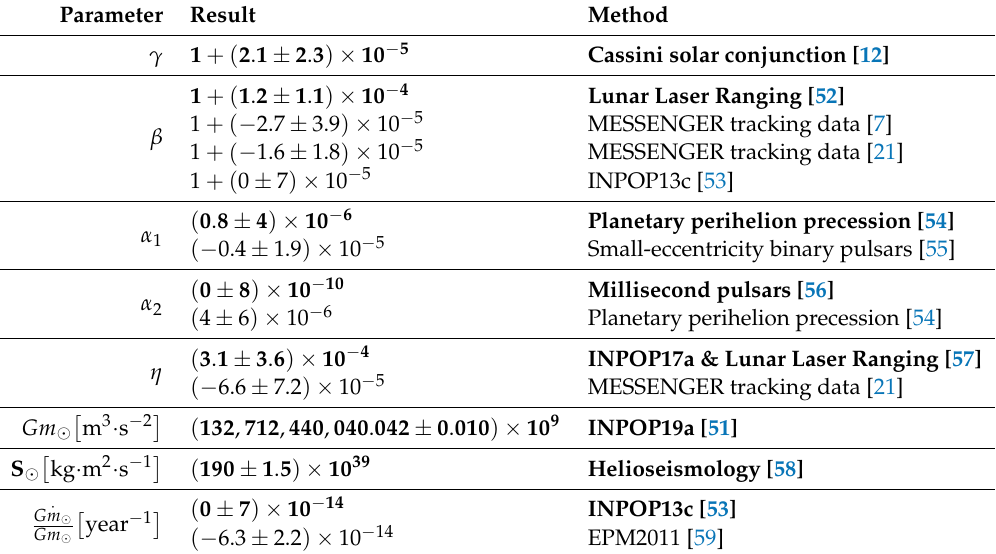
Table 1. Results of parameters from recent experiments. 1 σ values are given for uncertainties. For each parameter, the line in bold indicates what is used in this study as a priori information, the other values are included for